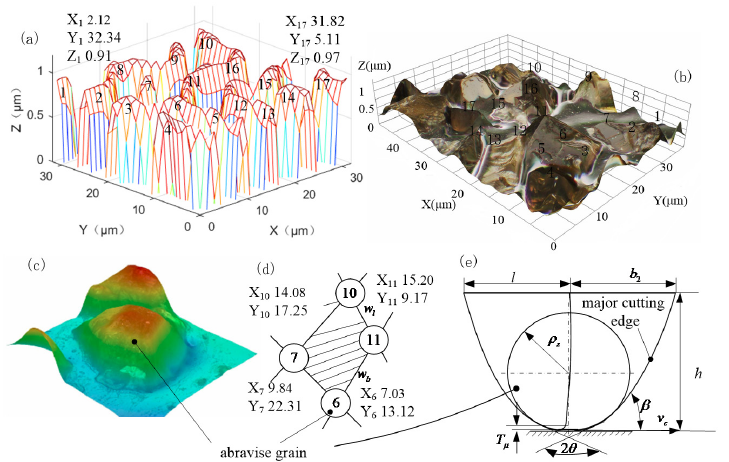
Figure 2. Modeling of randomly distributed active abrasive grain. ( a ) MATLAB simulation of microscopic geometry and distribution of CBN abrasive grains; ( b ) Microscopic geometry and distribution of CBN abrasive grains observed by digital microscope; ( c ) Microscopic geometry of single CBN abrasive grain; ( d ) Modeling of the space of active abrasive grains; ( e ) modeling of the geometry of single CBN